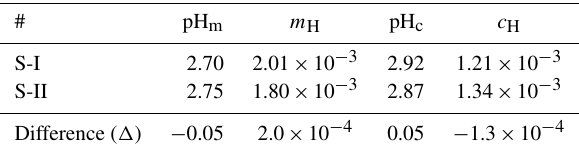
Table 3. Comparison of acidity of selected samples based on differ- ent